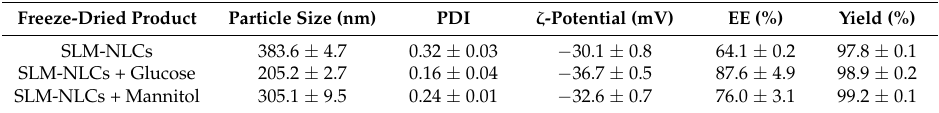
Table 3. Physicochemical characterization and reaction yields of SLM-NLCs after freeze-drying process. Light Scattering and High performance liquid chromatography (HPLC) analyses were performed after reconstitutions of the samples in water. Results are expressed as means ± standard deviation, n = 3.